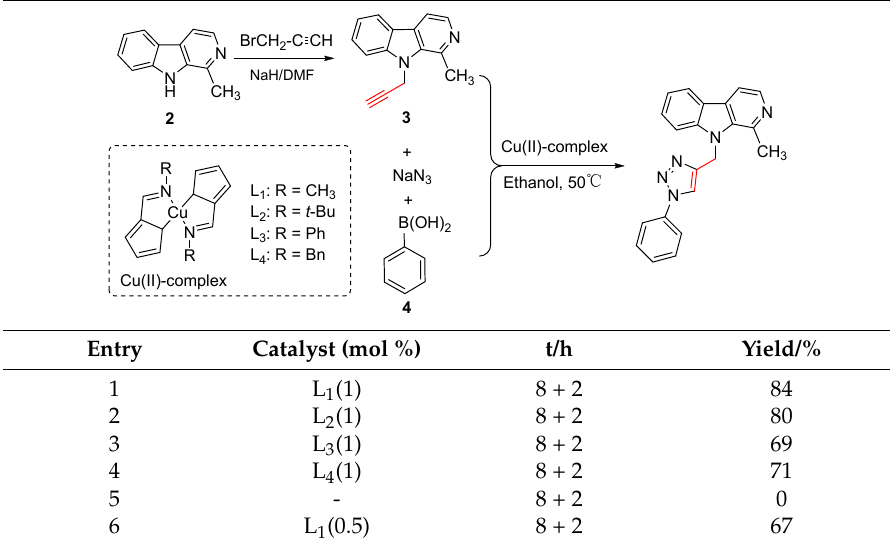
Table 1. Cu(II)-complex-catalyzed one-pot synthesis of aryl-1,2,3-triazole- β -carboline hybrids from phenylboronic acid in ethanol: optimization of the catalytic conditions.